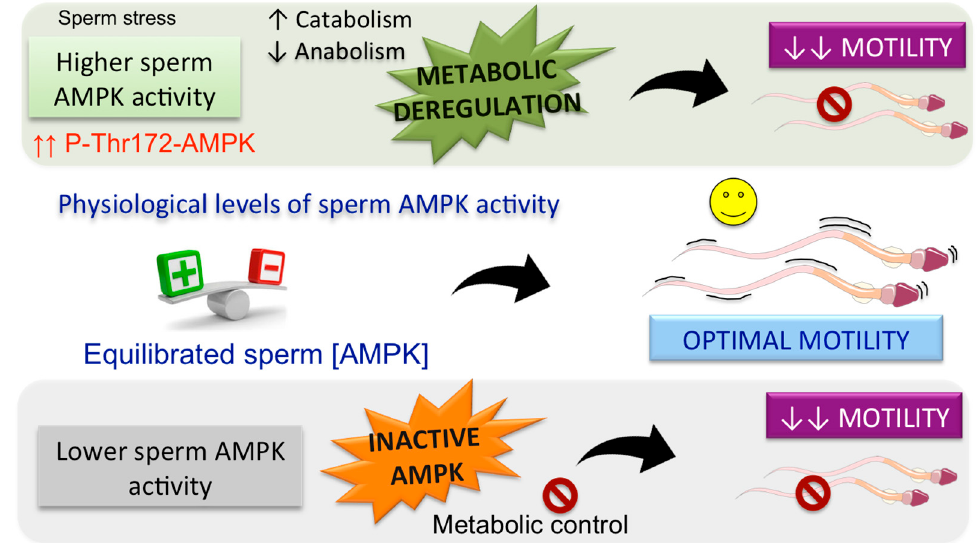
Figure 3. Different AMPK activity levels control spermatozoa motility. In vivo , during the spermatozoa transit trough the female reproductive tract, fluctuating levels of AMPK activity might occur in spermatozoa depending on the sperm energy demands. A physiological range of energy-charge regulated levels of AMPK activity is essential to accomplish optimal sperm motility that is adapted to the fluctuating extracellular conditions within the female reproductive tract. Up or down fluctuations of sperm AMPK activity cause a negative role in mammalian sperm motility.